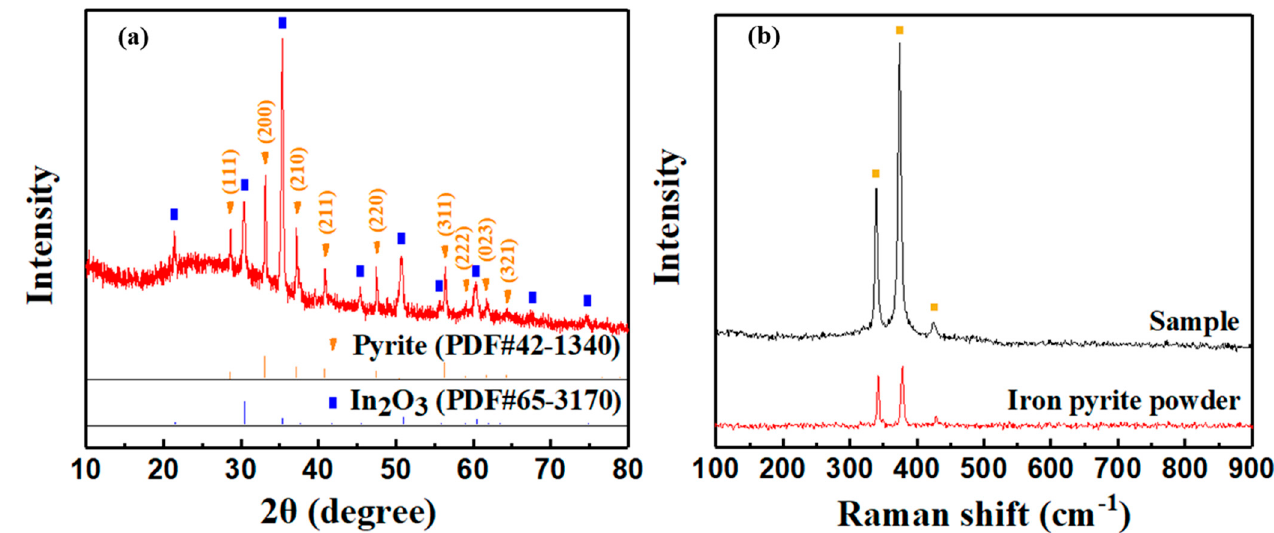
Figure 6. ( a ) XRD (film thickness is about 520 nm) and ( b ) Raman spectra of iron pyrite film. The Raman spectrum of pure iron pyrite powder is also given.